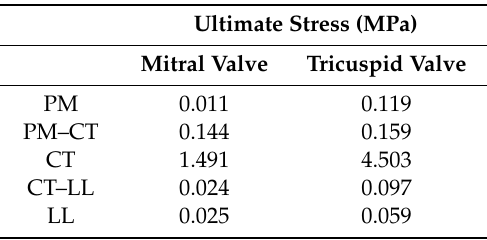
Table 1. Ultimate tensile strength (stress) determined from microscopy data of bisected samples reported in Figure 5. These peak stress values were reached by these regions before the samples were permanently deformed by application of